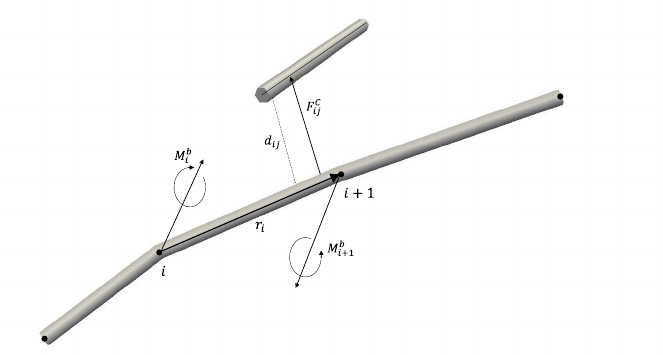
Figure 3. Fiber represented as a chain of segments. A neighboring fiber is also represented (adapted from